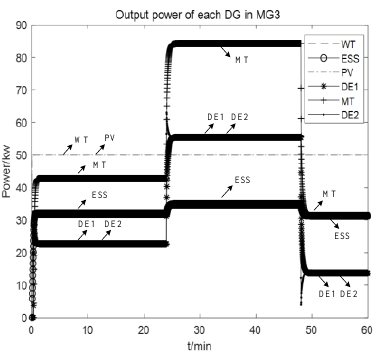
Figure 12. Output power of each DG.